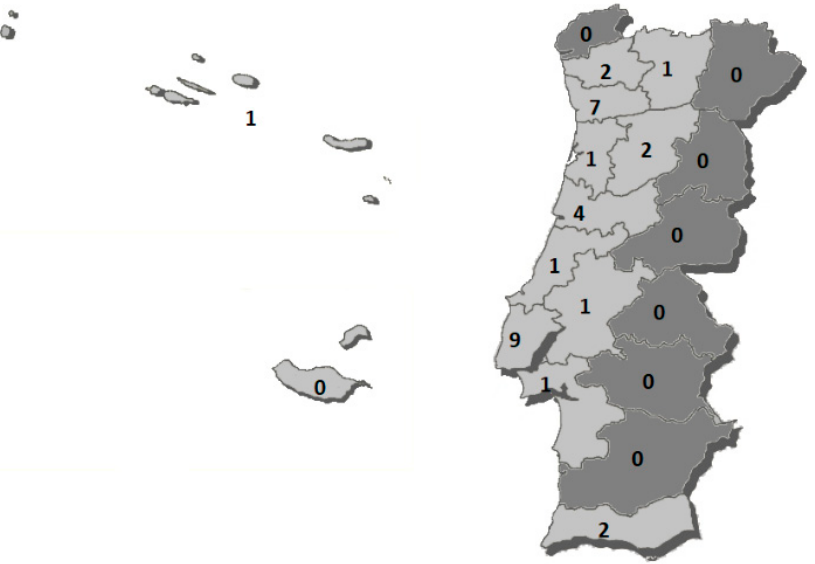
Figure 1. Distribution of athletes according to their districts in Portugal (light gray districts with athletes in the Tokyo 2020 Paralympic Games, dark gray districts without Paralympic athletes).